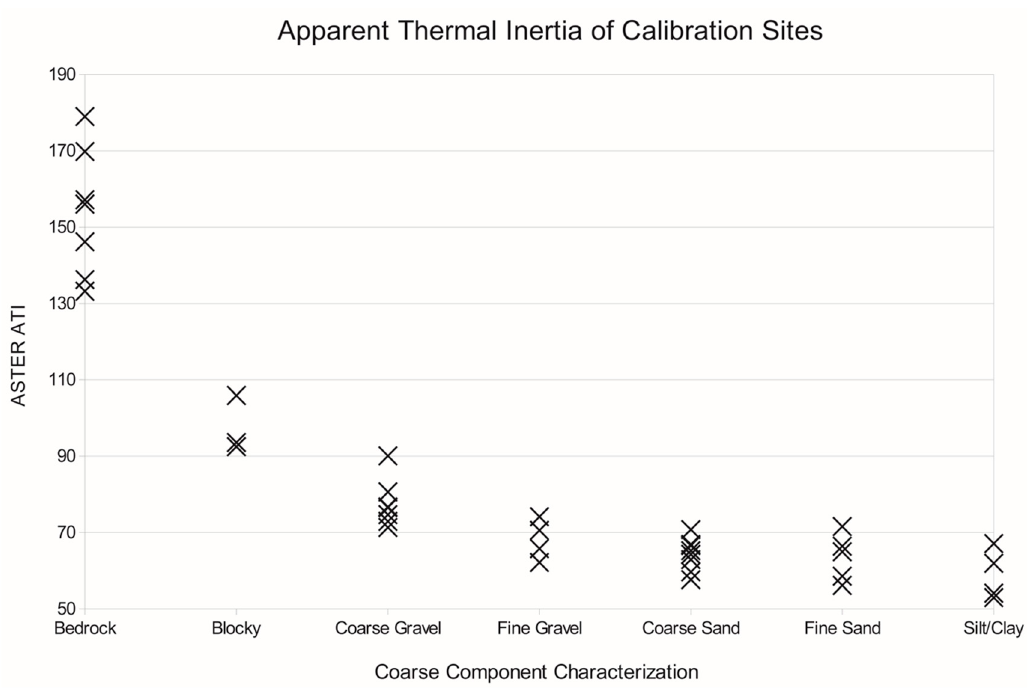
Figure 11. Plot of ATI values for 40 validation sites across the region.